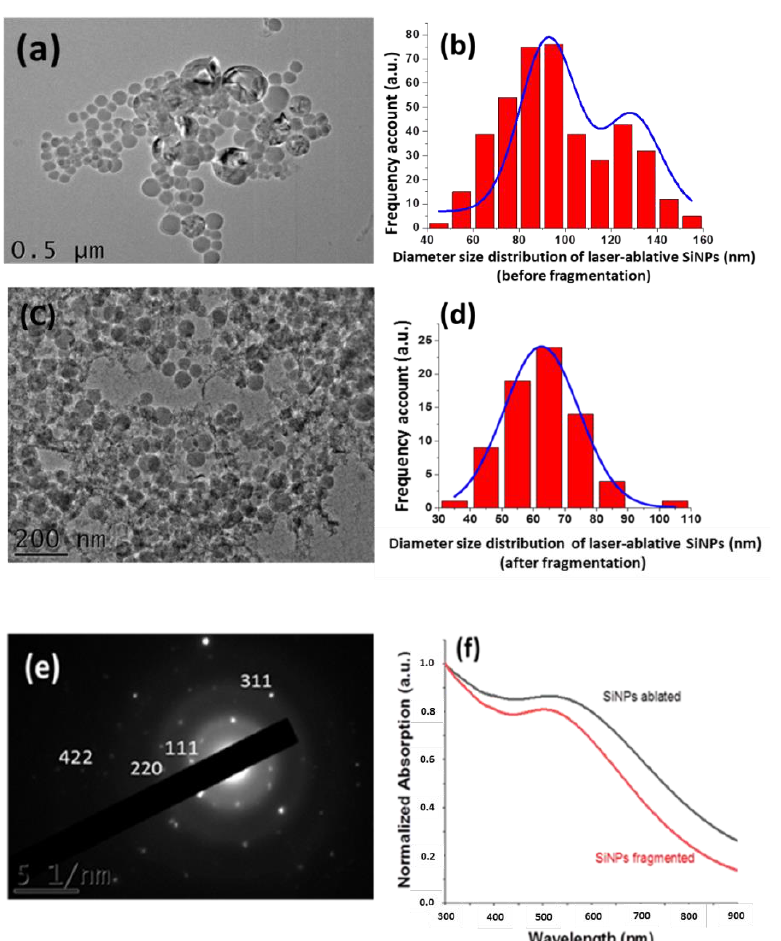
Figure 1. Typical HR-TEM image of SiNPs produced by laser-synthesis before ( a ) and after ( c ) fragmentation with corresponding diameter size distribution ( b , d ) respectively. ( e )Typical X-ray diffraction pattern of SiNPs obtained after fragmentation. ( f ) Absorption spectra of SiNPs elaborated by laser-synthesized process after ablation or fragmentation step in pure water.